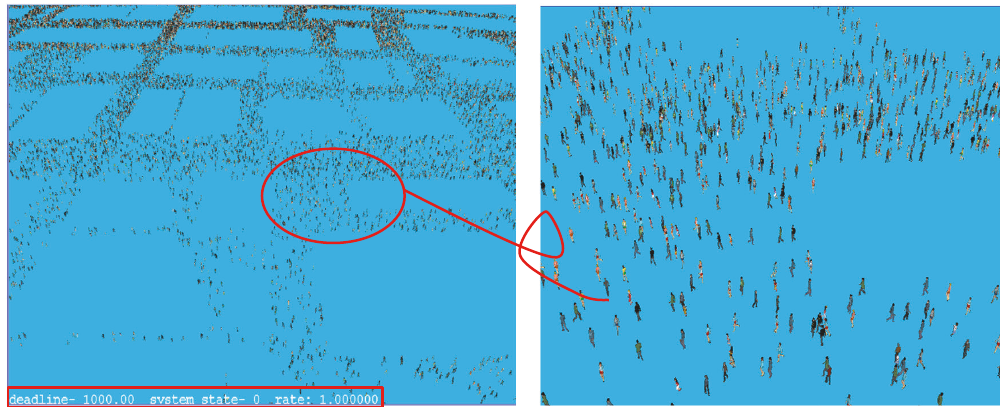
Figure 6: Rendering effect in State 0. The left picture shows that the group drawing vision is in State 0 and the drawing frame rate is 1.0 fps; the right picture shows the partial magnification. And we can see that the model accuracy is relatively high.